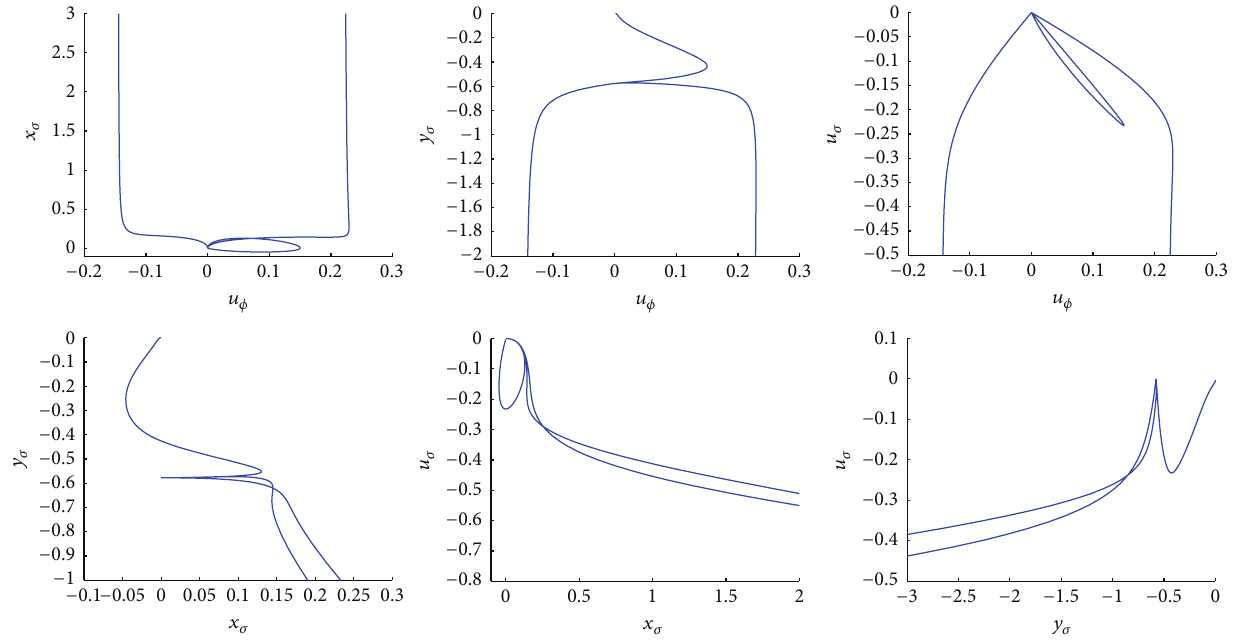
Figure 2: Two-dimensional projections of the phase-space trajectories for 𝜉 1 = 𝜉 2 = −𝜉 3 = 0.5 , 𝛼 𝜓 = 𝛼 𝜙 = −𝛼 𝜎 = 1.5 . All plots begin from the critical point 𝐵 being a stable